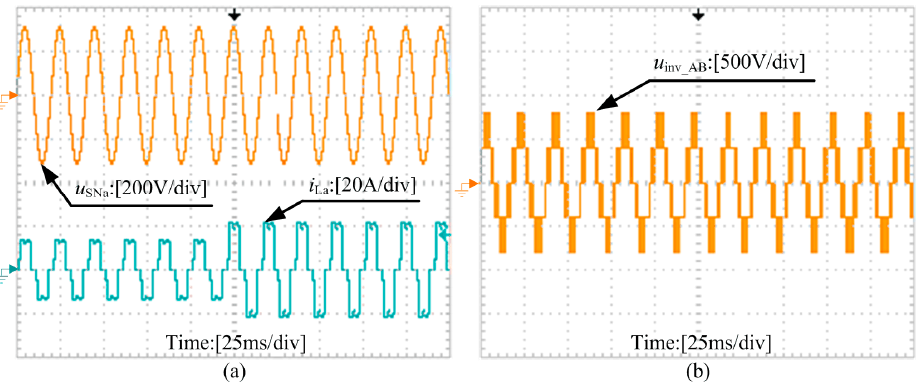
Figure 14. Experimental conditions of phase A. ( a ) Grid voltage and nonlinear load current; and ( b ) output line-to-line voltage of NPC.